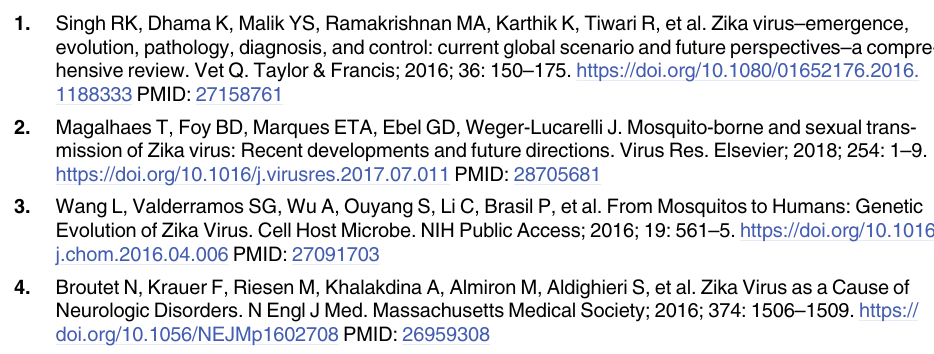
S1 Table. List of 96 filtered genes with p values of less than 0.01 in statistical t -tests. S2 Table. Details of all DEGs in hPNs, hNCCs, and mDCs. (XLSX) S3 Table. Top 10 significantly up- or downregulated pathways in hPNs, hNCCs, and DCs. (XLSX) S1 Fig. Network with significant pathways (p value < 0.05) common in hPNs, hNCCs, and mDCs. Protein-protein interactions were grouped by significantly expressed biological path- ways in hPNs (A), hNCCs (B), and mDCs (C). The nodes represent biological pathways, and node size depends on the betweenness centrality score calculated by network analysis. Edges were generated based on interactions of DEGs contained in pathways. Red: upregulated path- ways; blue: downregulated pathways. The networks were generated with v3.7.0 Cytoscape. (TIF) S2 Fig. The canonical pathway of prolactin signaling from IPA. Prolactin signaling consists of JAK/Stat signaling, PI3K signaling, and RAS